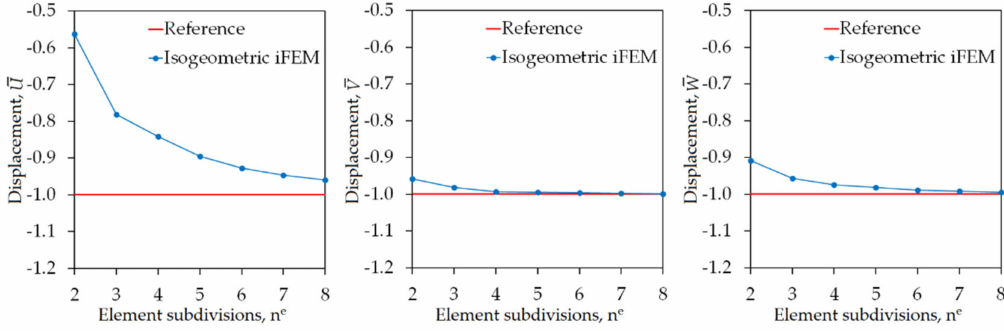
Figure 6. Convergence of maximum values of U , V , W displacements versus increasing number of element subdivisions n e for Scordelis–Lo